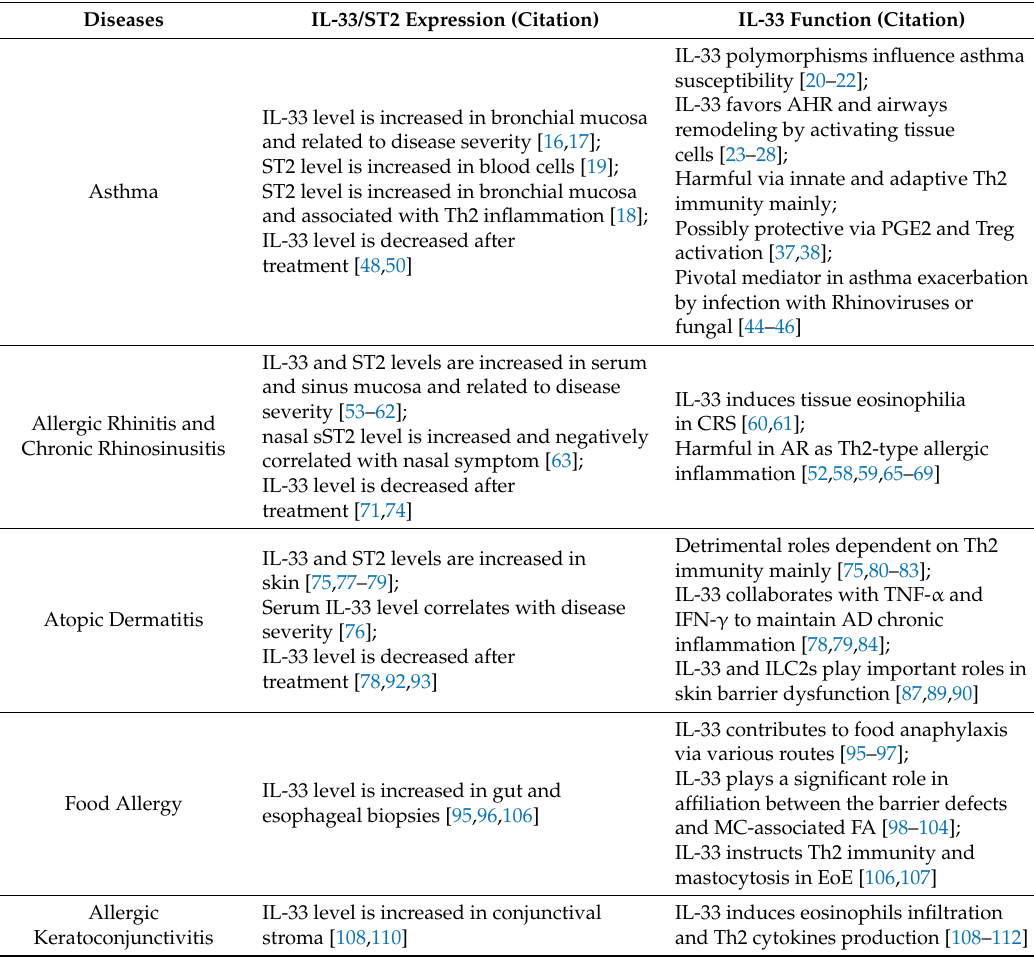
Table 1. IL-33/ST2 expression and function in allergic